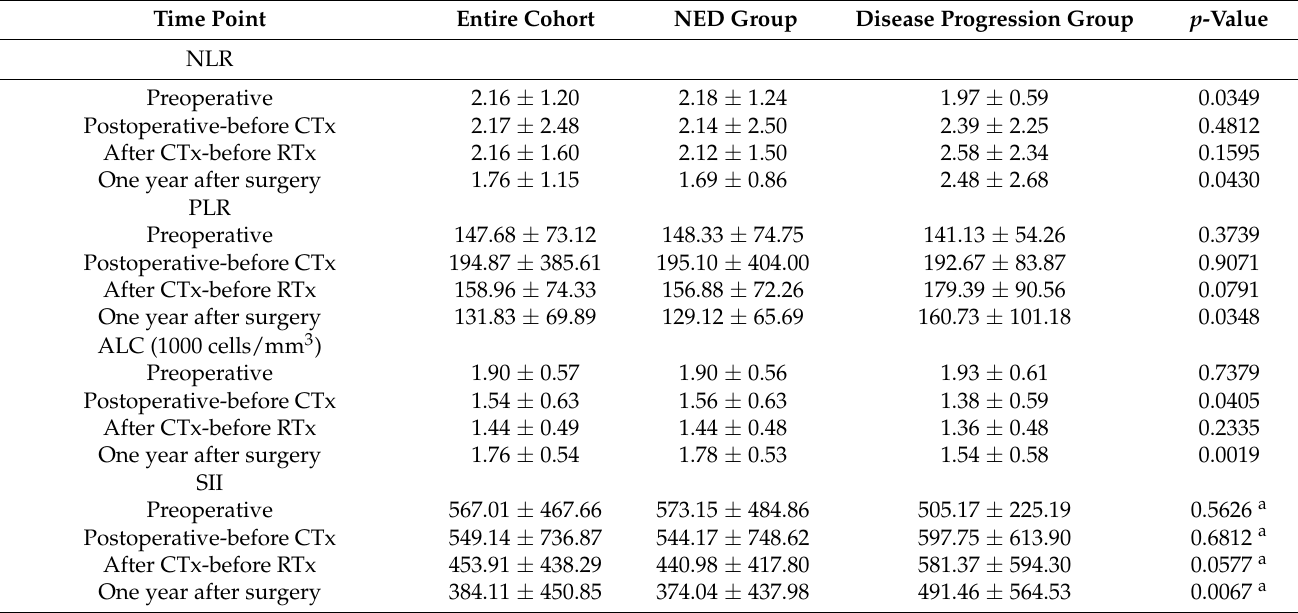
Table 2. Time-sequenced inflammatory biomarkers.